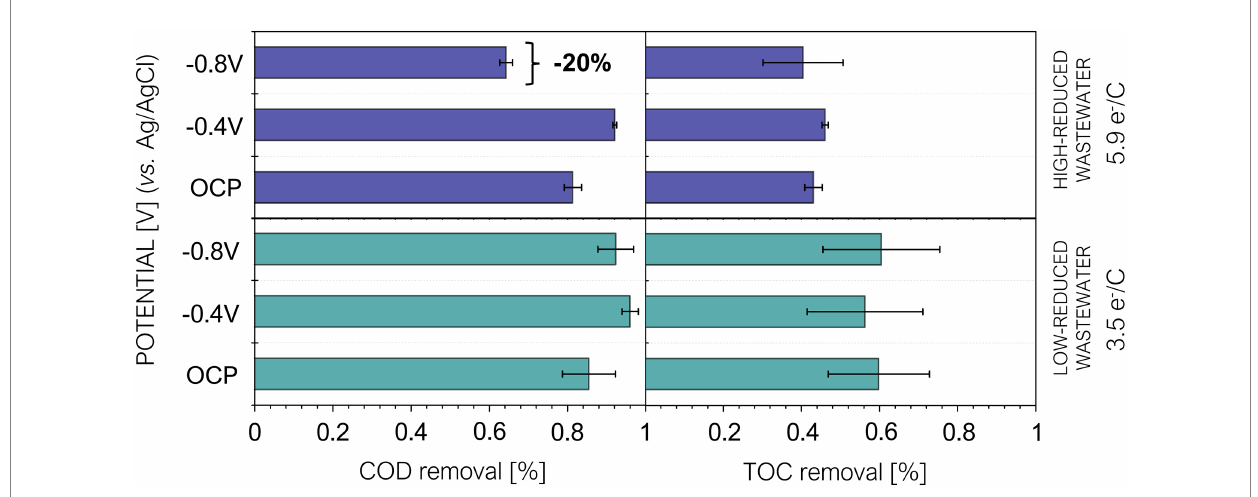
FIGURE 3 Chemical oxygen demand (COD) and total organic carbon (TOC) removals ± standard error under open circuit potential (OCP), − 0.4 V and − 0.8 V. HRT = 5 days. Purple bars correspond to reactors fed with high-reduced wastewater and blue bars corresponds to the reactors fed with low-reduced wastewater.